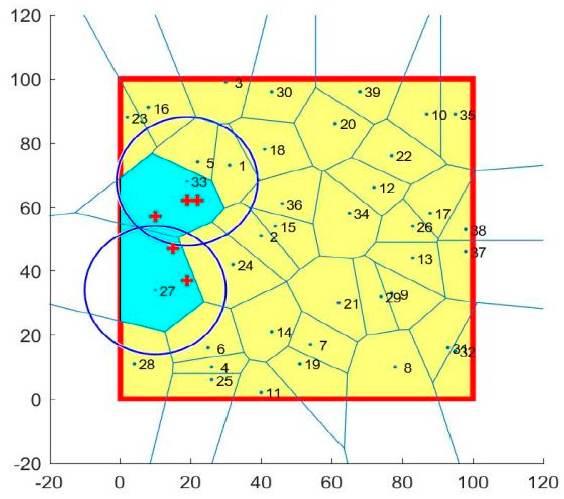
Figure 11. Point in polygon results.